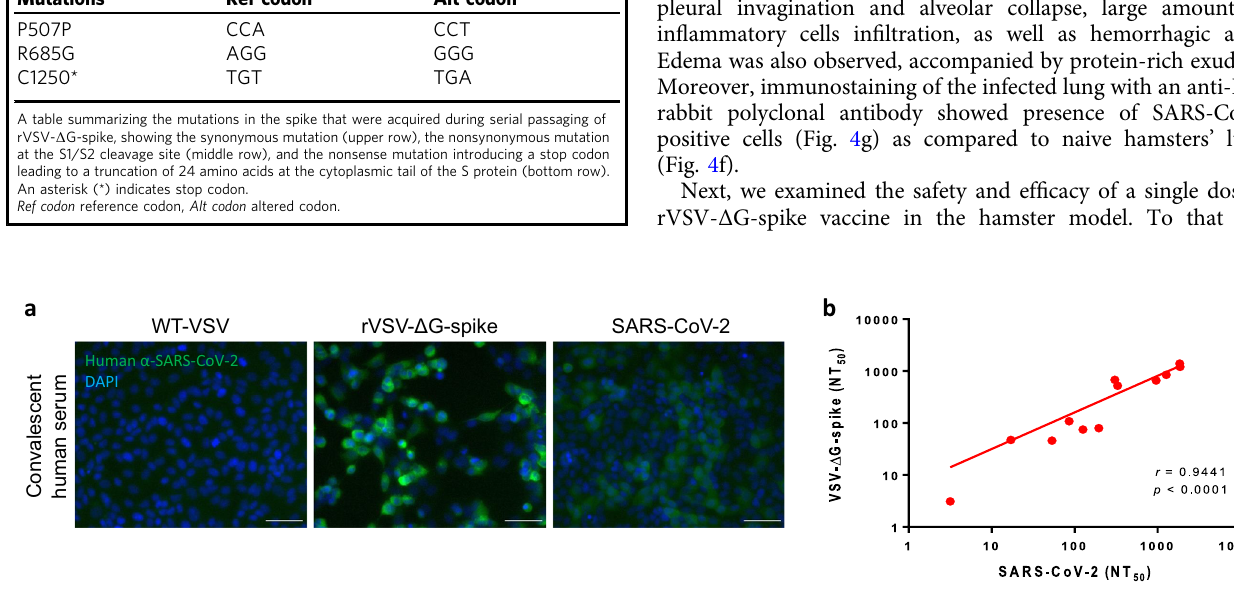
Fig. 3 Antigenic similarity of rVSV- Δ G-spike and SARS-CoV-2. a Immuno fl uorescent images of Vero E6 cells infected with either WT-VSV (left panel), rVSV- Δ G-spike (middle panel), or SARS-CoV-2, stained with COVID-19 human convalescent serum. Representative images of fi ve experiments are presented. Scale bars: 50 µ m. b Correlation analysis of neutralization of rVSV- Δ G-spike and SARS-CoV-2 by a panel of sera from COVID-19 convalescent patients. For each serum sample ( n = 12), NT 50 values were determined for neutralization of rVSV- Δ G-spike or SARS-CoV-2. The NT 50 values were plotted to determine the correlation between the neutralization assays. Spearman ’ s correlation r and p values are indicated. Source data are provided as a Source Data fi